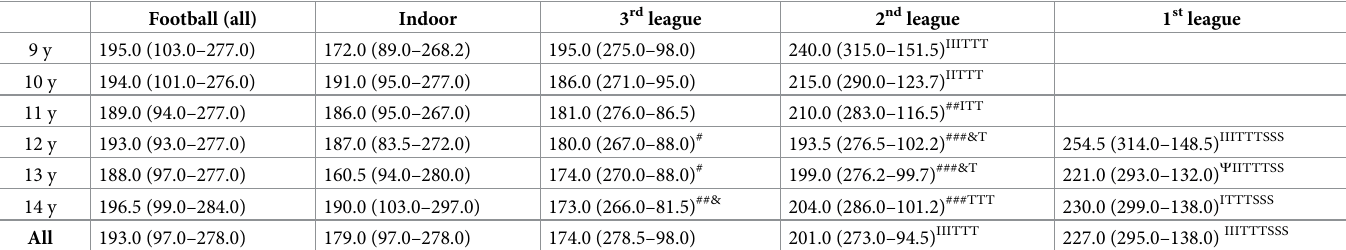
Table 3. Relative age of male football participants according to age group and league [medians and interquartile ranges (25th– 75th percentiles)]. Football (all) Indoor 3 rd league 2 nd